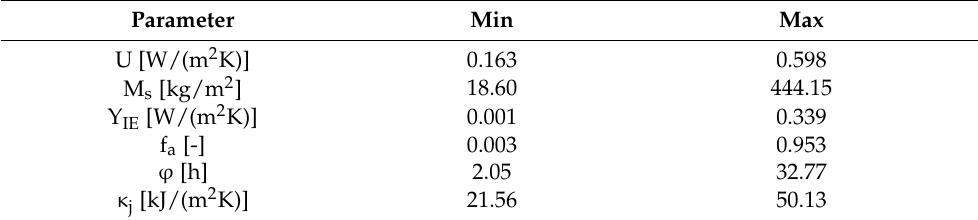
Table 4. Range of thermo-physical parameters of the walls